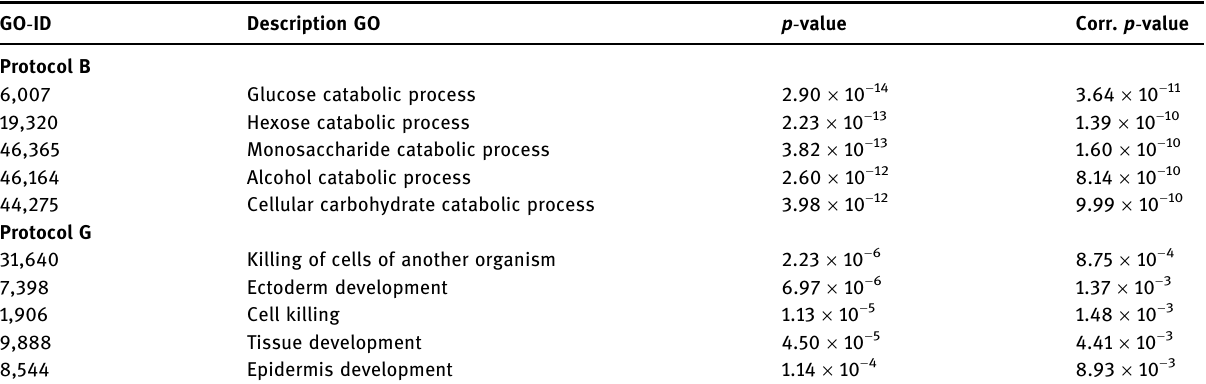
Table 3: GO categories of biological processes with the smallest p - values for proteins identi fi ed in the saliva sample prepared by the in - solution methods B and G